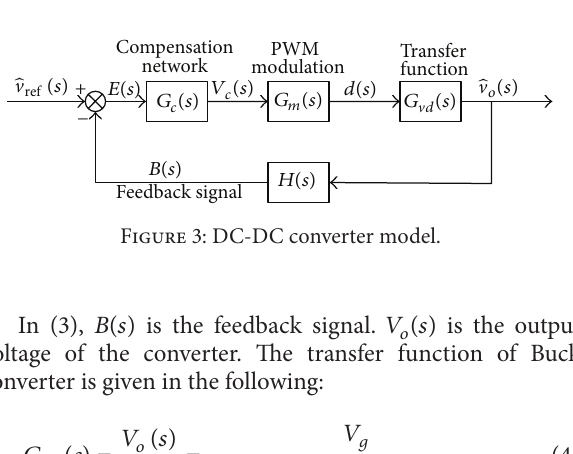
Figure 2: Block diagram of the PWM closed-loop control unit.